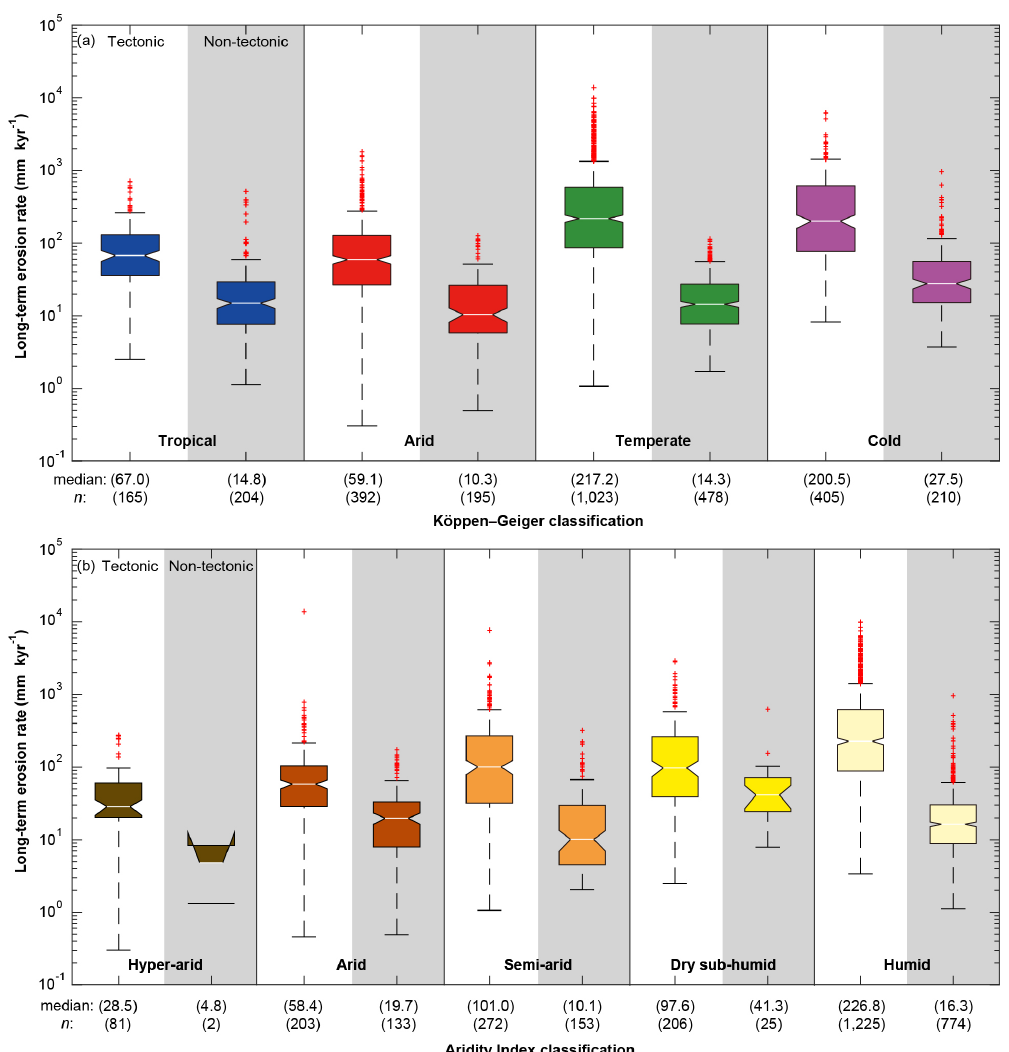
Figure A2. Long-term erosion rates classified by tectonic (white backgrounds) and non-tectonic regions (grey backgrounds) for climate zones of Köppen–Geiger climate classification (a) and Aridity Index classification (b) . Long-term erosion rates in tectonic regions are all higher than in non-tectonic regions across all climate